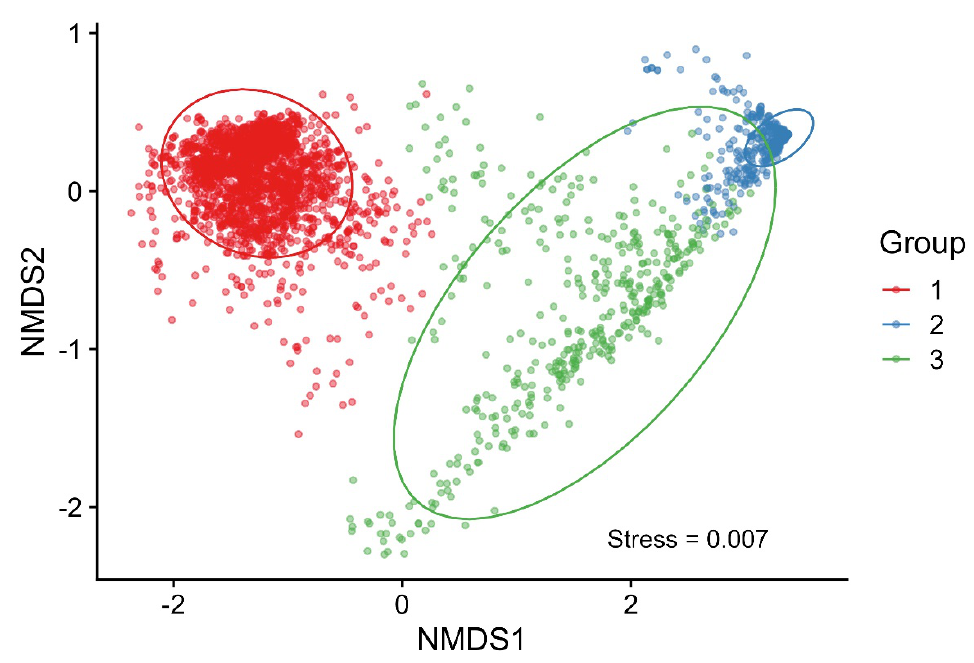
Figure 4. Groupings based on a nonmetric multidimensional scaling (NMDS) analysis. The analysis resulted in three groups. Group 1 comprises resistant combinations with bacterial growth, as well as phage-free controls. Group 2 comprises susceptible combinations with bacterial killing. Group 3 comprises in-between combination. A total of 2869 entities are shown on the plot. Ellipses indicate a 95% confidence level based on a multivariate t-distribution. Stress < 0.01 = a good fit.